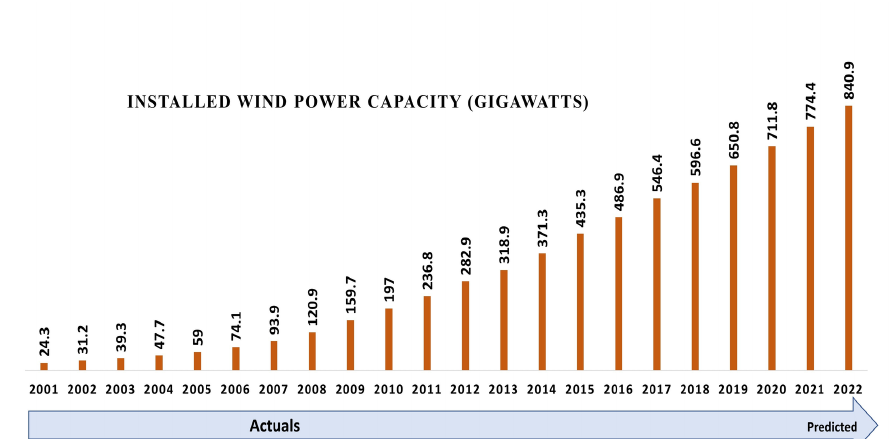
Figure 1. Globally installed wind power capacity. Reused with permission from Ref. [3]. Copyright 2021